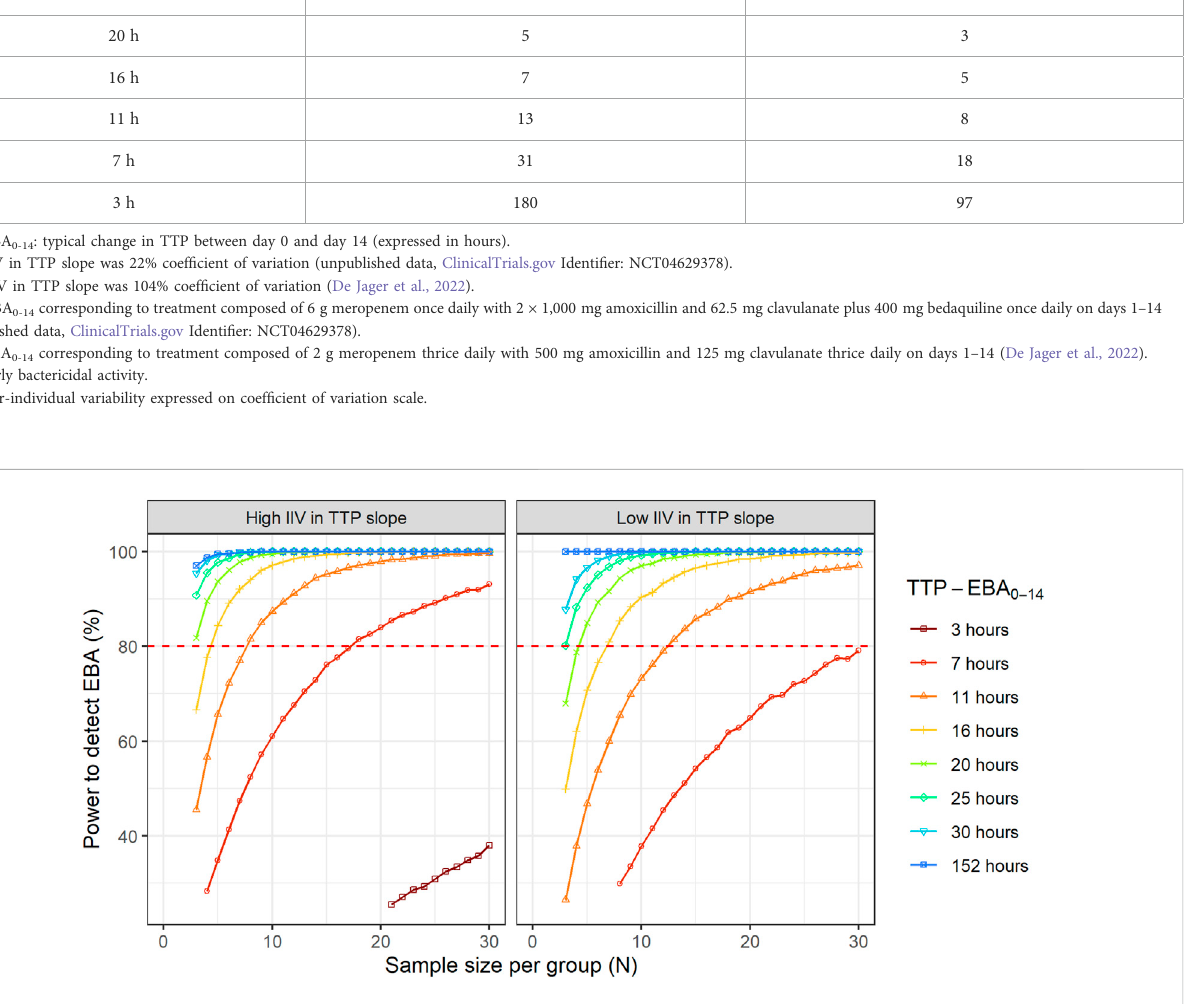
FIGURE 8 The impact of change in time-to-positivity between days 0 and 14 (TTP-EBA 0-14 ) on sample size per arm and power to detect early bactericidal activity(EBA).Lowandhighinter-individualvariability(IIV)inTTPslope arerepresentedby22%and104%coef fi cientofvariation (CV). Thereddashedline represents 80%